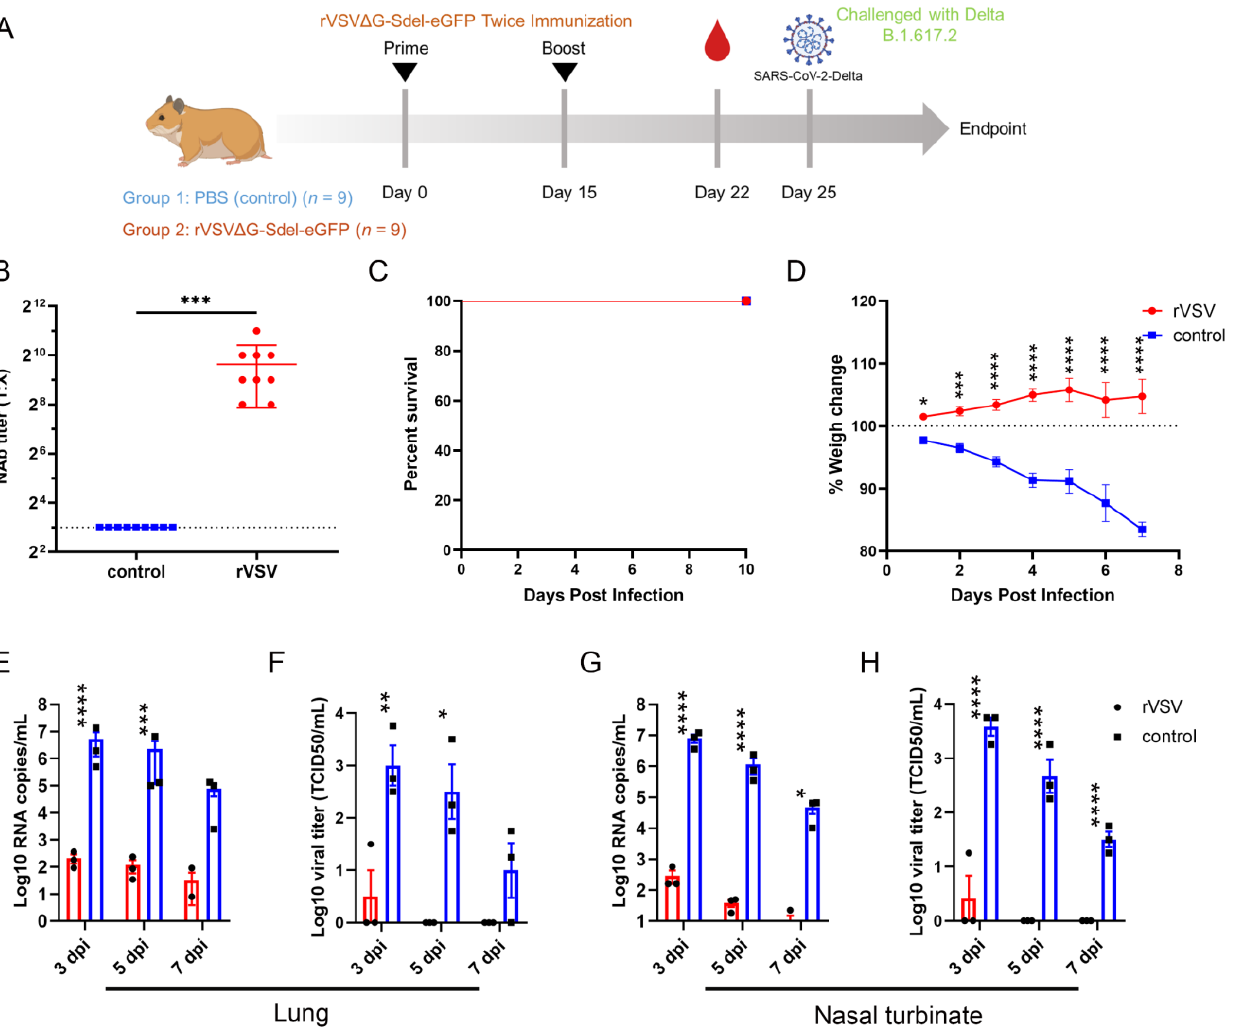
Figure 6. Immunogenicity evaluation of recombinant viruses in Syrian hamsters. ( A ) Immunization and challenge strategy. Syrian hamsters (nine animals per group) were intranasally immunized with recombinant viruses (2 × 10 6 TCID 50 /animal) or PBS (control). Animals were boosted at a 15-day interval. Blood samples were collected at 22 days post vaccination. On day 25, Syrian hamsters challenged 10 5 TCID 50 /animal SARS-CoV-2 Delta variants. ( B ) The titer of neutralizing antibodies against rVSVΔG -Sdel-eGFP in Syrian hamsters. ( C ) Survival rate of Syrian hamster. ( D ) Weight changes of Syrian hamsters. ( E – H ) Viral RNA copies ( E , G ) and viral titer ( F , H ) of lungs and turbinate samples. A statistical analysis was determined using a Student's t -test or two-way ANOVA analysis. * p < 0.05, ** p < 0.01, *** p < 0.001, **** p < 0.0001.